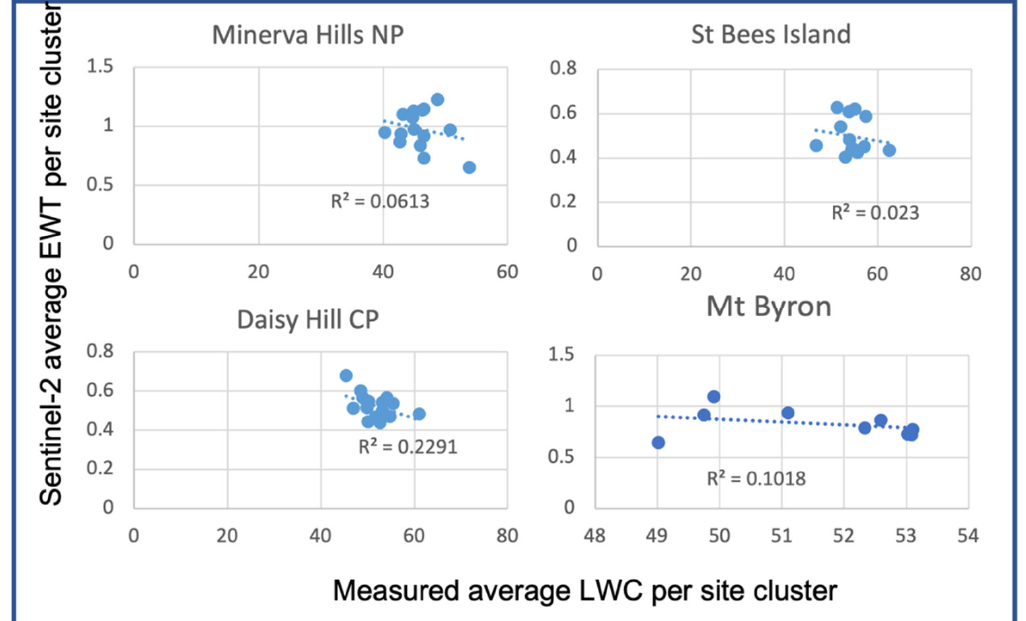
Figure A6. Comparing field measured LWC and Sentinel-2 clusters EWT.